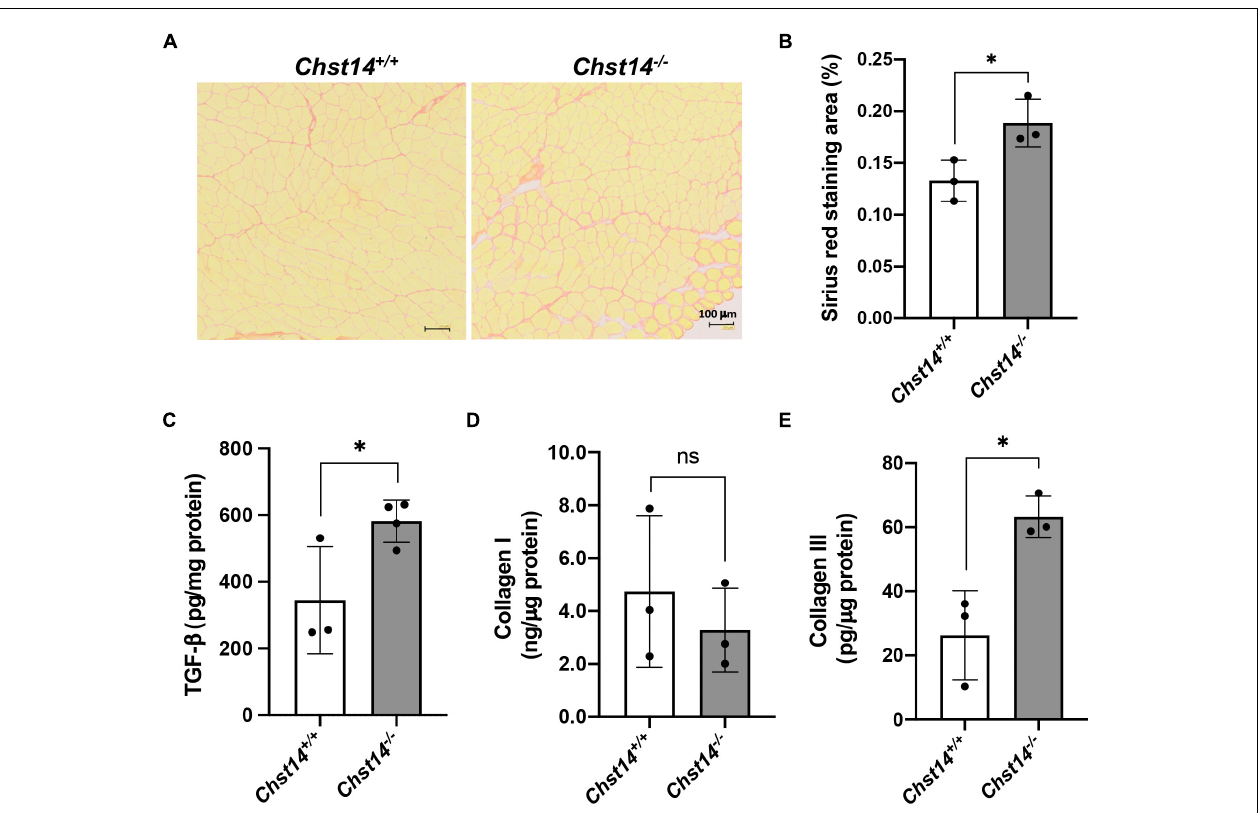
FIGURE 3 | Fibrosis in DS-deficient muscles. (A) Sirius red staining of the tibialis anterior (TA) muscle of 1-year-old sex-matched Chst14 + / + and Chst14 − / − mice. Bars, 100 µ m. (B) Quantification of sirius red staining area of the cross-section (% of total area) from 1-year-old sex-matched Chst14 + / + and Chst14 − / − mice ( n = 3, each). (C–E) Quantitative measurement of TGF- β (C) , collagen type I (D) , and collagen type III (E) in the muscle lysate from 1-year-old sex-matched Chst14 + / + and Chst14 − / − ( n = 3, each) mice using ELISA. All data are presented as mean ± standard deviation, and statistical differences between Chst14 + / + and Chst14 − / − (* P < 0.05), t -test. ns, not